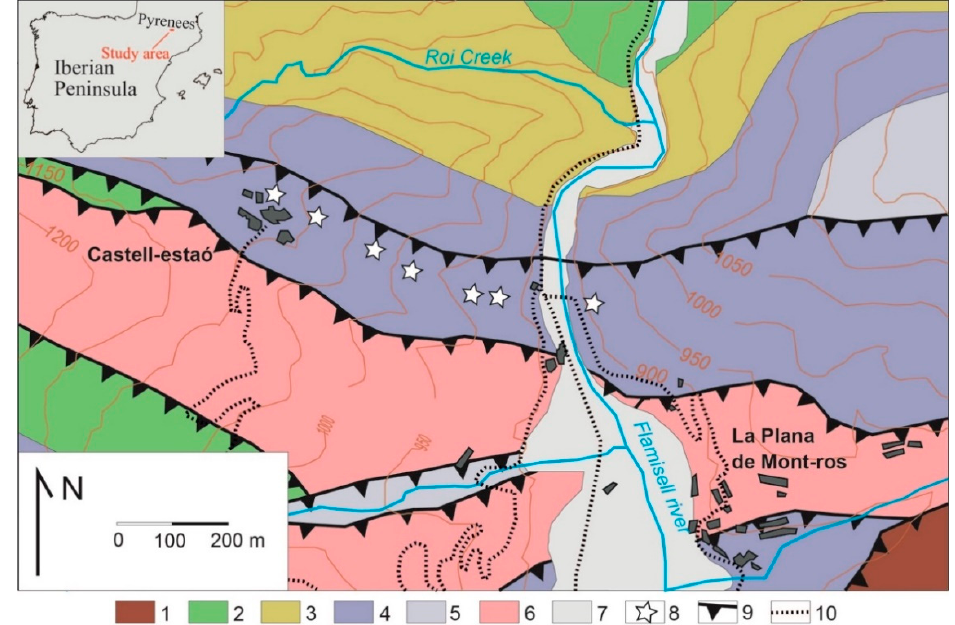
Figure 1. Geological map of the studied area. 1, Black shales (Silurian); 2, limestones (Devonian); 3, turbidites (Carboniferous); 4, sandstones, conglomerates, mudstones and coal (Buntsandstein facies, Lower Triassic); 5, limestones (Muschelkalk facies, Middle Triassic); 6, sandstones, gypsum, mudstones (Keuper facies, Upper Triassic); 7, alluvial sediments (Quaternary); 8, mining operations; 9, thrust; 10, road. Modified after the ICGC [28].